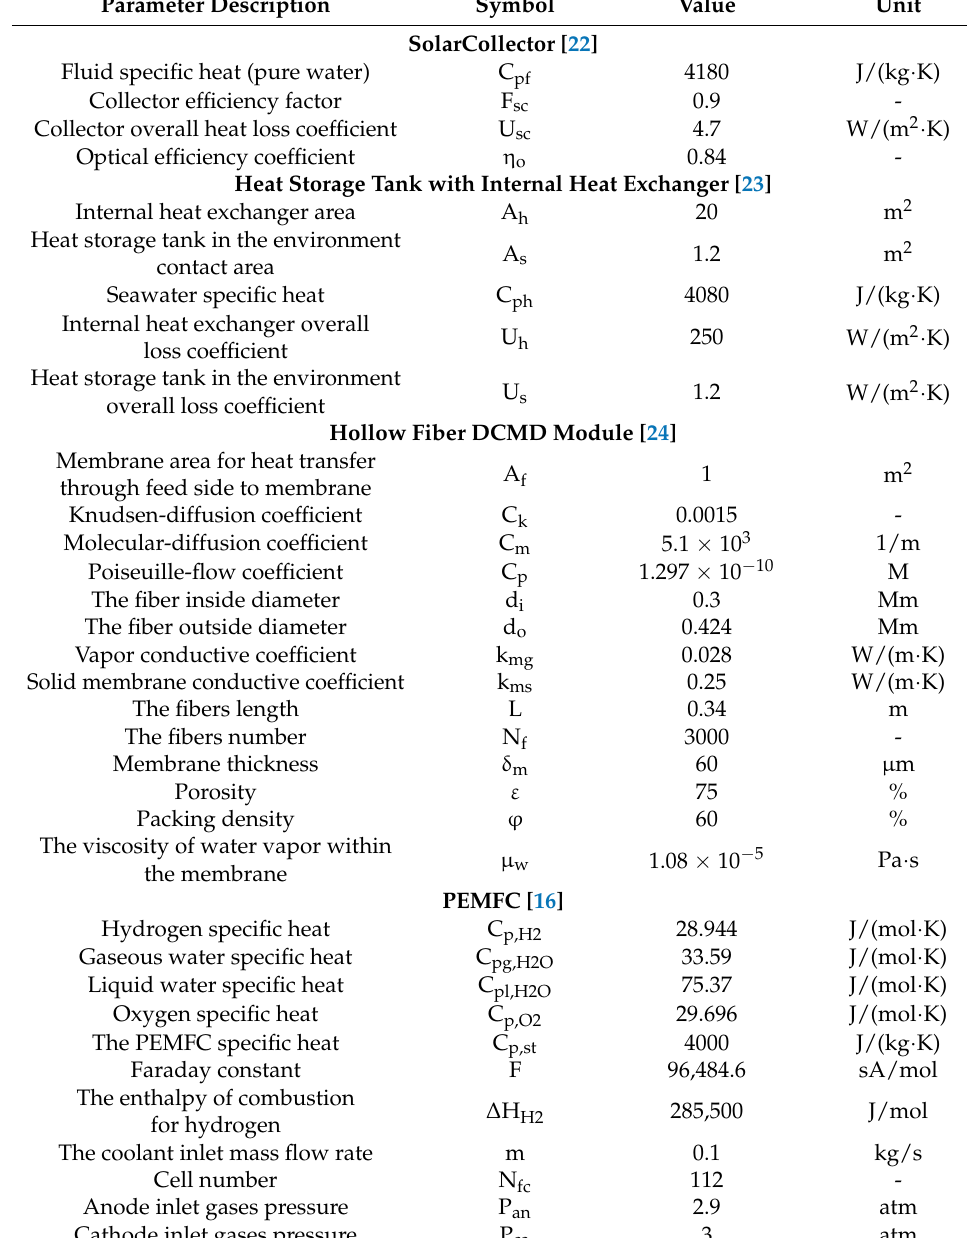
Table 1. Characteristics of two kinds of membrane distillation